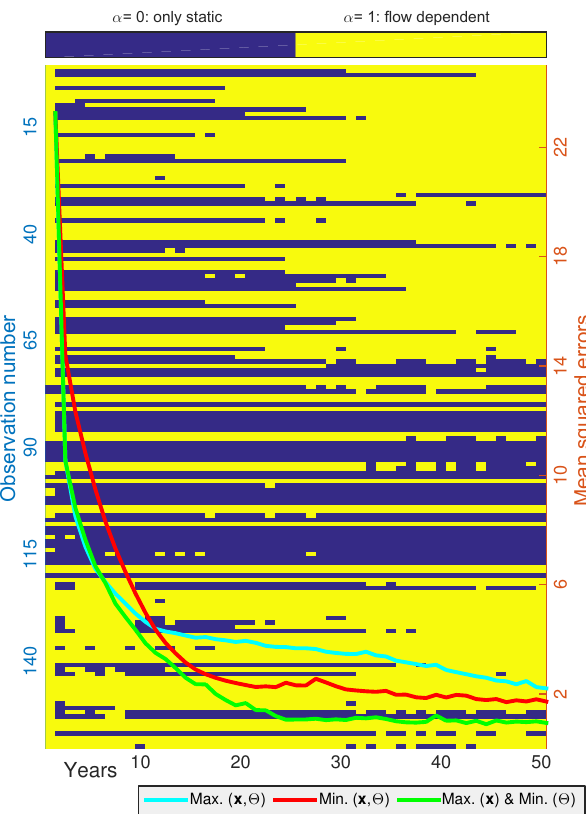
Figure 11. The colored image shows, according to the left y axis, the adaptive change in α values for each individual observation. The observation index (1 ,..., 160) is sorted such that the first 40 in- dices correspond to PCE measurements, the second 40 correspond to TCE, third 40 correspond to DCE and finally VC takes the last 40 indices. The yellow color indicates that no background covariance matrices have been used and the blue color suggests that only en- semble “flow-dependent” statistics are involved. The curves demon- strate the change in MSE, according to the right y axis, in time when maximizing the information gain (cyan), minimizing the informa- tion gain (red) and maximizing the formation for concentration and minimizing it for degradation rates (green).